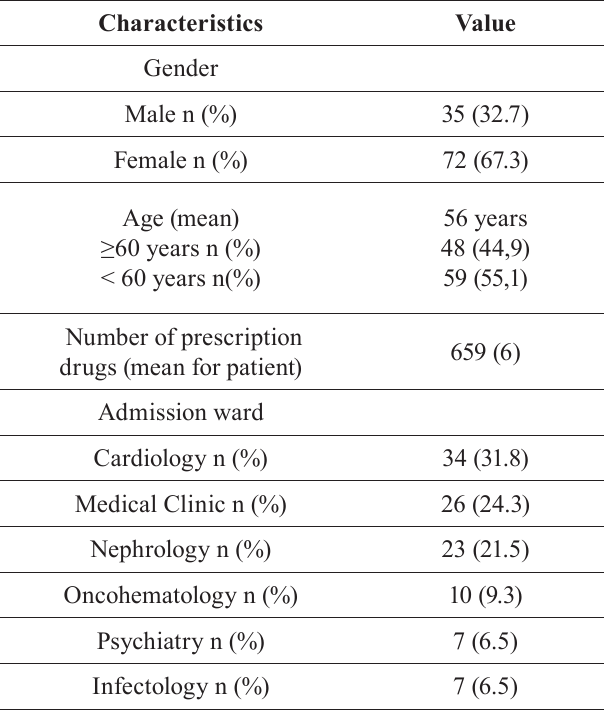
TABLE I - P atient characteristics and distribution by admission ward (n = 107)